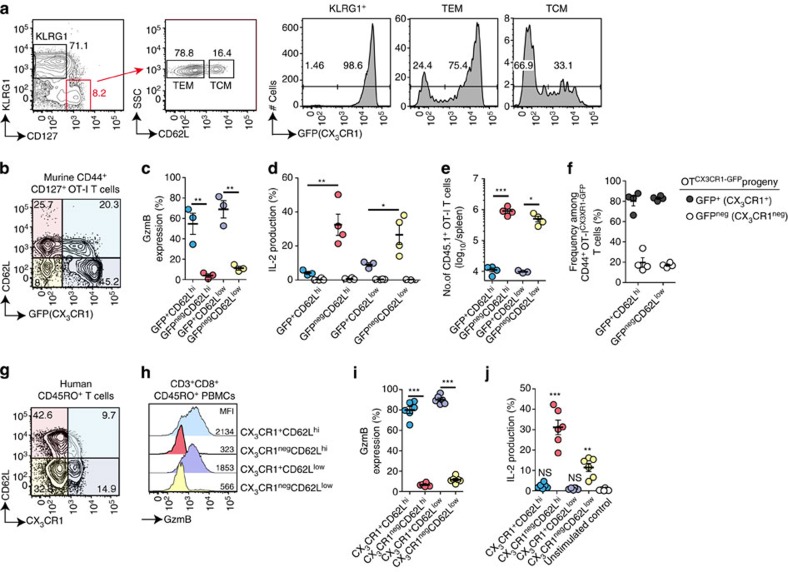
CX3CR1 and CD62L expression identifies four distinct memory CD8+ T-cell populations.(a–f) Naive CD45.1+ OT-I CX3CR1-GFP T cells (5 × 102) were adoptively transferred into CD45.2 mice subsequently infected with AdOVA. (a) At 60 d.p.i., CX3CR1 expression was determined in CD45.1+ OT-I-derived KLRG1+ T cells, CD62LlowCD127+CD44+ memory T cells (TEM) and CD62LhiCD127+CD44+ memory T cells (TCM) isolated from the spleen. (b) Representative analysis of CD62L and GFP (CX3CR1) expression in CD127+ CD44+ memory OT-ICX3CR1-GFP T cells from a. (c,d) Four populations of CD127+ CD44+ memory OT-ICX3CR1-GFP T cells after AdOVA infection separated by CD62L and GFP (CX3CR1) expression levels were (c) analysed for GzmB expression or (d) sorted and analysed for IL-2 expression after PMA/ionomycine stimulation for 5 h. Unstimulated T cells from each population (empty circles) served as control. n=3 or 4 for each group; *P<0.05, **P<0.01, ANOVA. (e,f) Adoptive transfer of identical numbers (2 × 103 cells) of FACSorted CD45.1+ cells from the four populations of memory T cells into CD45.2+ mice (n=4) that were subsequently infected with AdOVA. (e) At 8 d.p.i., total numbers of CD45.1+ T cells and (f) frequencies of CX3CR1+ cells among CD45.1+ T-cell progeny was determined in the spleen. *P<0.05, ***P<0.001, ANOVA. (g) Representative analysis showing CD62L and CX3CR1 expression in human CD45RO+CD3+CD8+ PBMCs. (h,i) Flow cytometric determination of expression of GzmB in the four cell populations stratified by CD62L and CX3CR1 expression. ***P<0.001, ANOVA. (j) IL-2 expression in FACSorted cells from these four T-cell populations subjected to PMA/ionomycine stimulation for 5 h. **P<0.01 and ***P<0.001, ANOVA. Fluorescence-activated cell sorting (FACS) plots are representative for three (a–c) or five (g,h) independent experiments. Data from one of three independent experiments are show in c–f each dot represents T cells from one mouse. (i,j) Pooled data for T cells from n=6 individual donors.